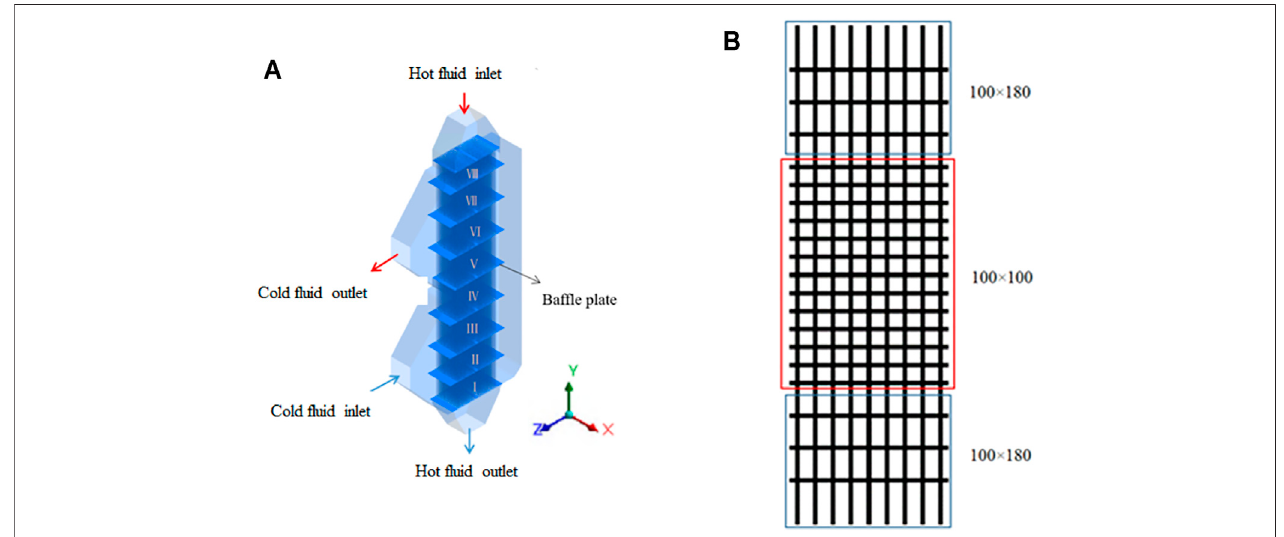
FIGURE 1 | Diagram of model: (A) baf fl e plate heat exchanger and (B) grid.